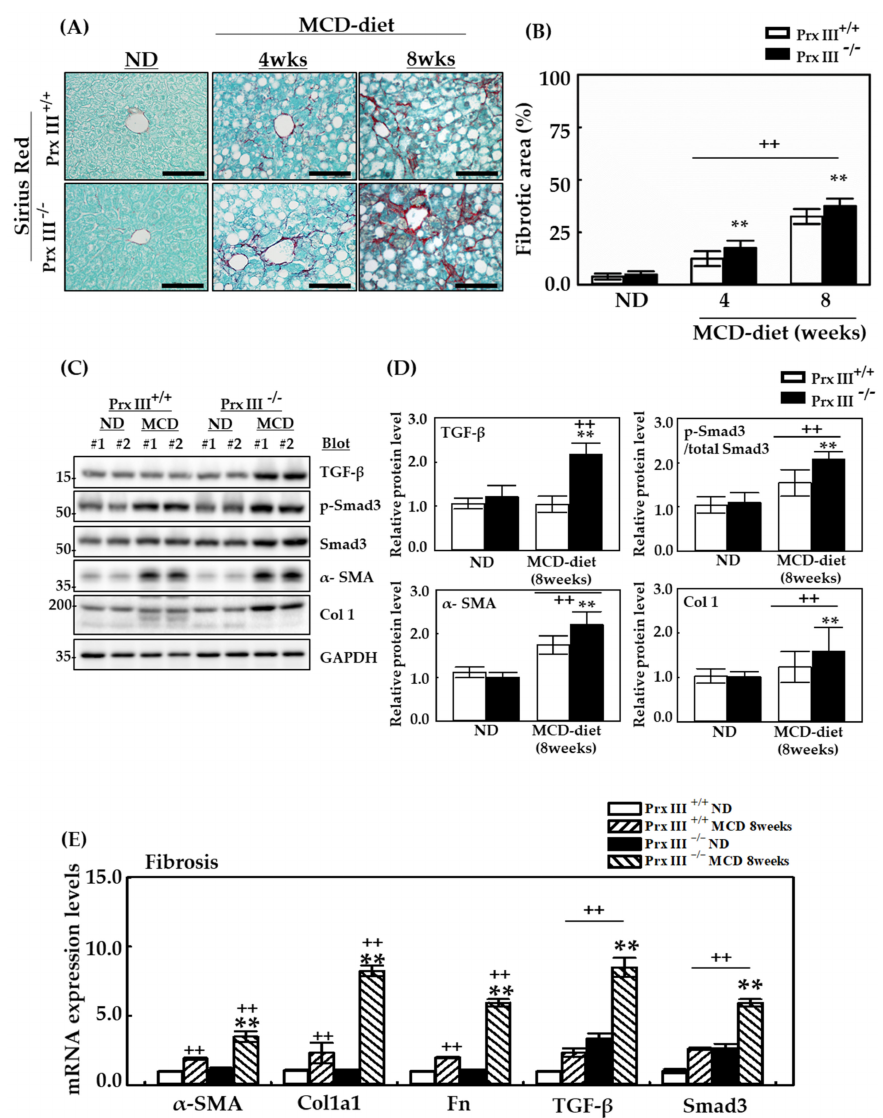
Figure 6. Effects of Prx III deficiency on hepatic fibrosis using Sirius Red staining and mRNA expression levels associated with liver inflammation. Prx III +/+ and -/- mice were fed the ND or MCD diet for 4 and 8 weeks. Liver tissues obtained from mice sacrificed at 4 and 8 weeks were fixed with 4% formaldehyde in phosphate-buffered saline at 4 ◦ C overnight and embedded in paraffin. The liver sections (4 µ m thick) were stained with Sirius Red to reveal the major collagen deposition marker. ( A , B ) F4/80 staining in liver tissues from Prx III +/+ and Prx -/- mice fed the ND or MCD diet for 4 and 8 weeks were quantified by NIS-Elements AR 3.1 software. The scale bars indicate 100 µ m, with original magnifications of 400 × ; Expression levels of fibrosis marker proteins in the liver of Prx III +/+ and -/- mice. ( C ) Protein expression levels normalized against GAPDH protein. ( D ) Real-time PCR was performed to assess mRNA levels of liver inflammation-related genes in mice fed the ND or MCD diet for 8 weeks. mRNA isolated from liver tissues using TRIzol reagent was subjected to RT-PCR and quantitative PCR. Each expression level of mRNA was normalized to GAPDH mRNA. ( E ) The mRNA expression levels of liver fibrosis-related genes in Prx III +/+ and -/- mice fed the ND or MCD diet for 8 weeks Data are means ± SE from three independent experiments, with four to six mice per group. ++ p < 0.01 vs. control group mice fed ND, ** p < 0.01 vs. the MCD diet-fed Prx III +/+mice. These results, along with mRNA expression levels of alpha smooth muscle actin ( α - SMA), collagen (Col), Fn1, TGF- β and Smad3 suggest that Prx III deficiency induces